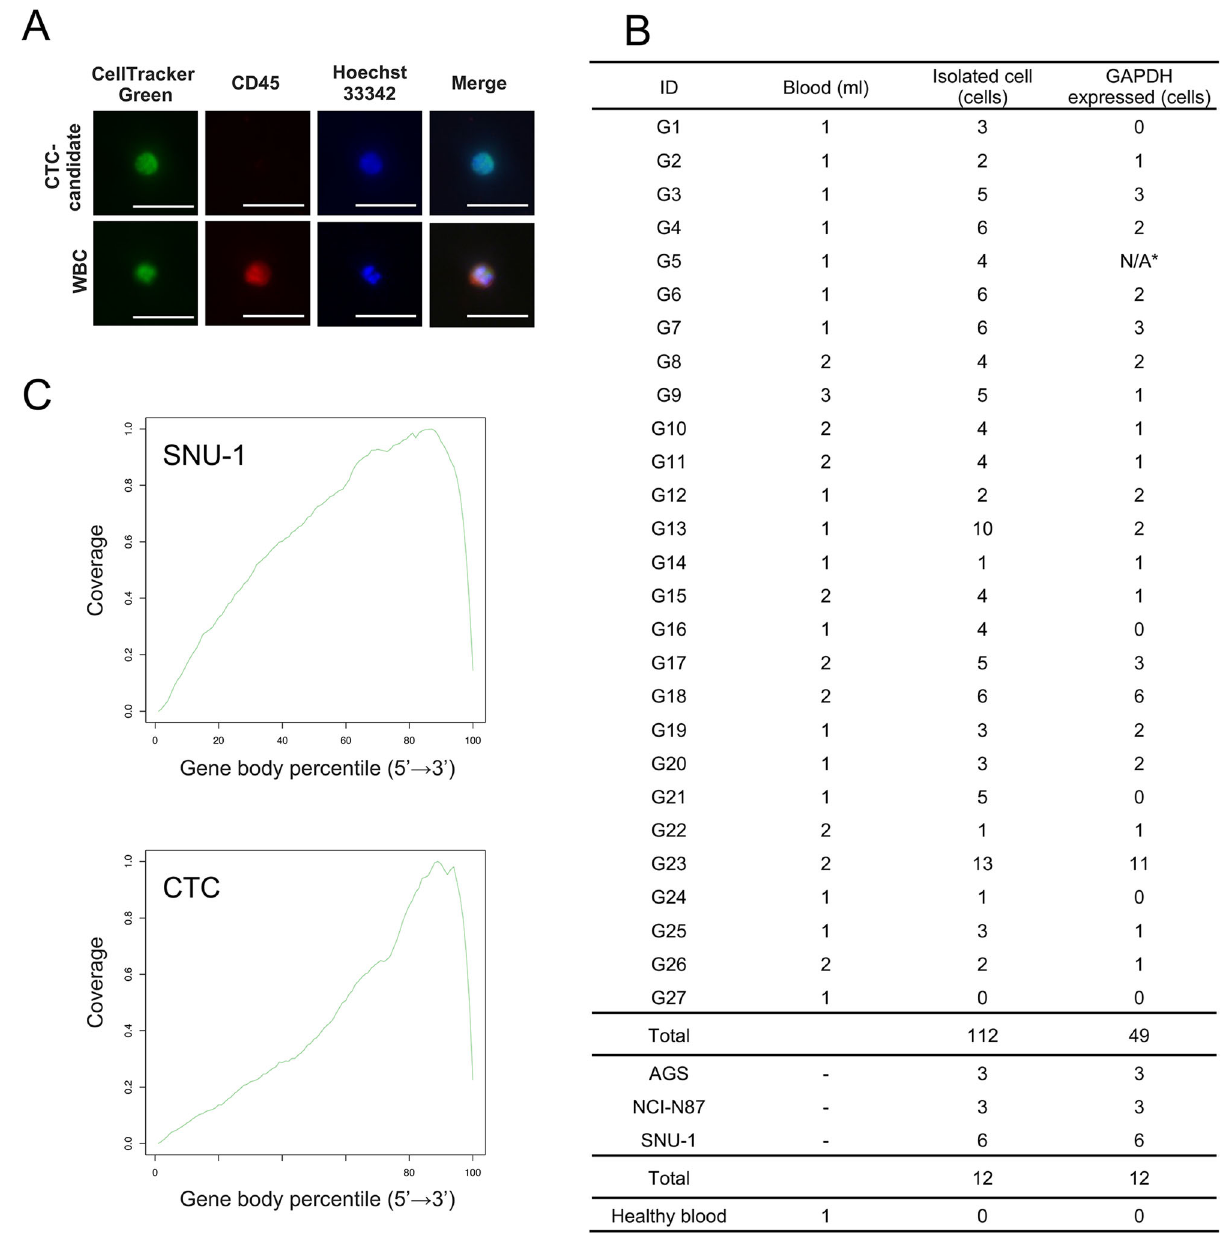
Fig. 2 Isolation of gastric CTCs and RNA-seq analysis. A Fluorescence image of a representative CTC-candidate and WBC. Scale bar: 50 μ m. B Summary of CTC isolation and quality control. Samples in G5 were lost by technical error (N/A*). C Gene body coverage from a single SNU-1 cell and gastric